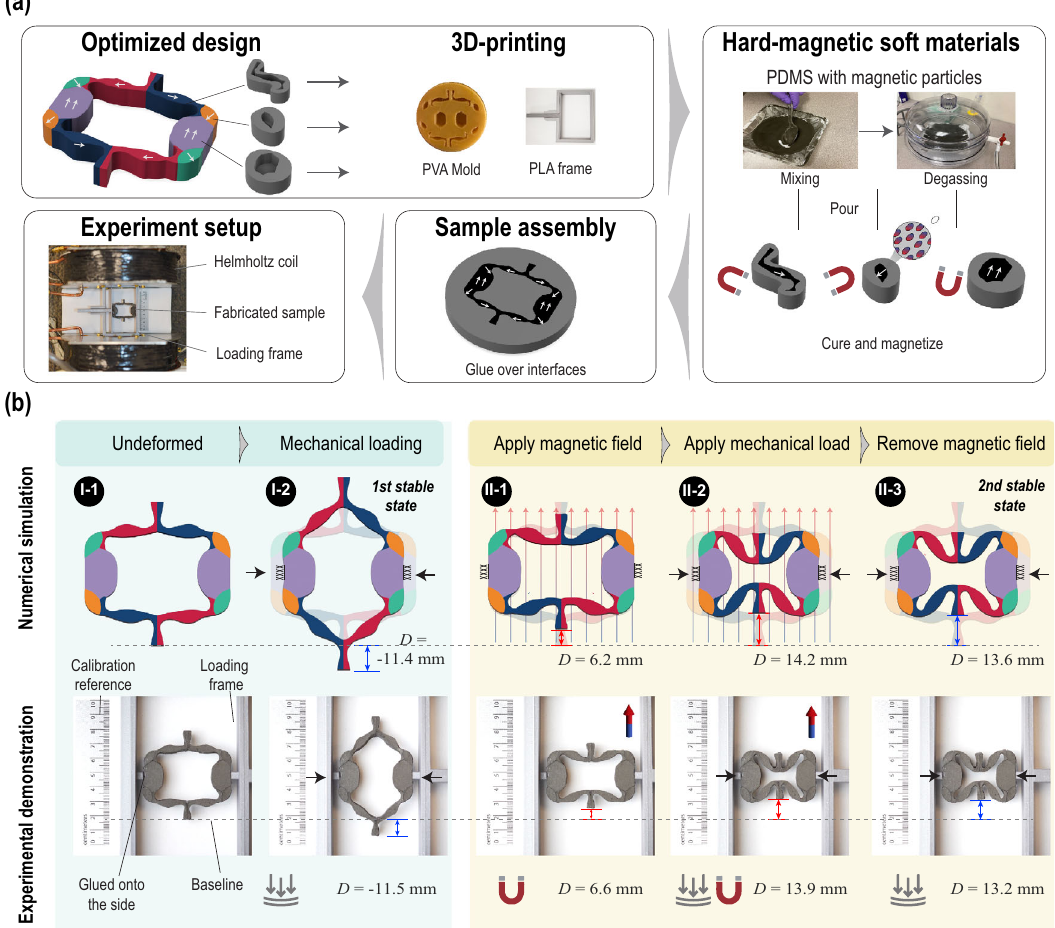
Fig. 5 Numerical analysis and experimental validation of the bistability and reprogrammable deformation modes in the optimized magneto-active metamaterial unit design. a Illustrations of fabrication approach and experimental setup; b Comparison of numerical and experimental